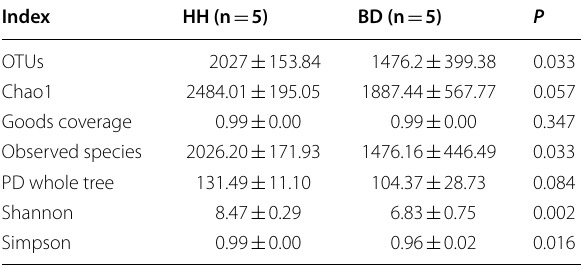
Table 2 Alpha-diversity indices of BD and